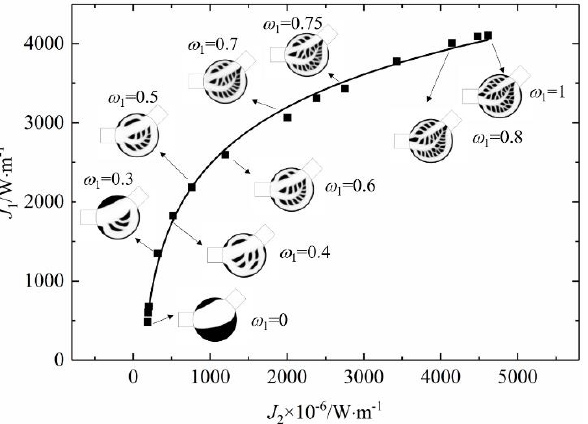
Figure 7. Optimal solutions, Pareto frontier, and corresponding optimal topology configurations under different ω 1 values.